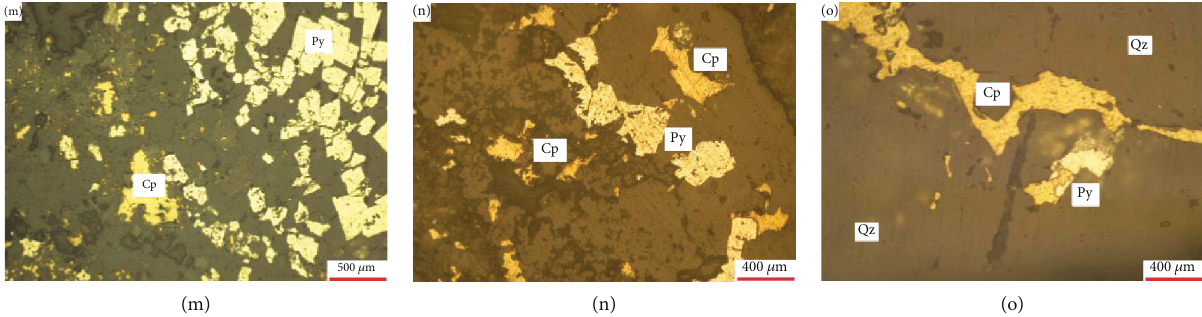
Figure 7: Macroscopic and microscopic characteristics of the granite porphyries in the Yangla copper deposit, Yunnan, China. (a) Grayish- white massive granite porphyry. The quartz crystals are semiautomorphic or elongated grains, and the plagioclase phenocrysts, which underwent strong alteration, appear corroded. (b) Grayish-white massive structure granite porphyry with veinlets of metal sul fi des (pyrite and chalcopyrite) and quartz. (c) Grayish-white massive structure granite porphyries with large amounts of veined metal sul fi des (pyrite and chalcopyrite). (d) Grayish-white massive structure granite porphyry with large amounts of quartz veins. (e) Gray massive structure granite porphyry with large amounts of disseminated pyrite, chalcopyrite, and bornite. (f) Light-grayish to white massive structure granite porphyry with metal sul fi de veins (pyrite and chalcopyrite), quartz veins, and disseminated bornite. (g) Porphyritic texture granite porphyry. The phenocrysts are semiautomorphic or elongated grains, the quartz is corroded, and the matrix is microscopic granular plagioclase – quartz. (h) Granite porphyry with blastoporphyritic texture. The phenocrysts are sericitic plagioclase, and the matrix is plagioclase – quartz with a felsitic texture. (i) Granite porphyry with blastoporphyritic texture. The phenocrysts are sericitic plagioclase, the quartz is corroded, and the matrix is microscopic granular plagioclase – quartz. (j) Porphyritic texture granite porphyry. The phenocrysts are automorphic granular quartz and faded biotite, and the matrix is microscopic granular plagioclase – quartz. (k) Granite porphyry with blastoporphyritic texture. The phenocrysts are sericitic plagioclase and faded biotite, and the matrix is microscopic granular plagioclase – quartz. (l) Quartz – sul fi de veins developed in the granite porphyry. (m) Disseminated chalcopyrite and pyrite. (n) Xenomorphic granular pyrite and chalcopyrite developed along fi ssures in alternating scattered-disseminated and irregular fi ne-veined forms. The pyrite is interspersed with chalcopyrite. (o) Chalcopyrite and pyrite in- fi lled along the quartz veins. The pyrite is xenomorphic and interspersed by chalcopyrite. Qz: quartz; Pl: plagioclase; Bi: biotite; Py: pyrite; Cp: chalcopyrite. Table 2: Statistical of the mineralization elements in granite porphyries and surrounding rock, in the stope 41 # , 3250 meters section, Yangla copper deposit, Yunnan,